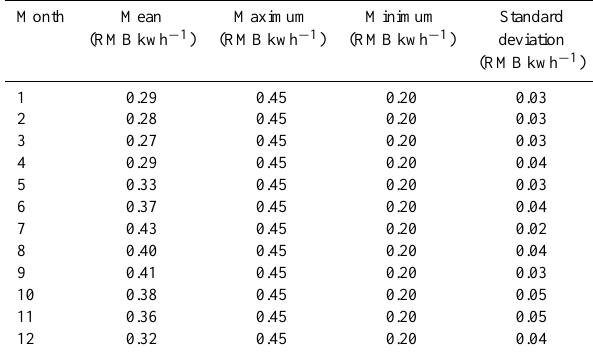
Table 1. Details of price variations in the day-ahead